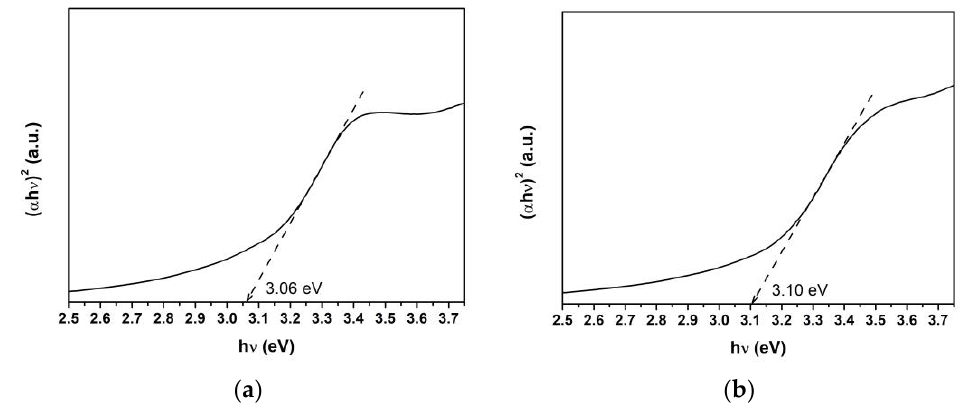
Figure 8. Band gap energy estimation using the Tauc plot for ( a ) ZnO and ( b ) Ti-ZnO.